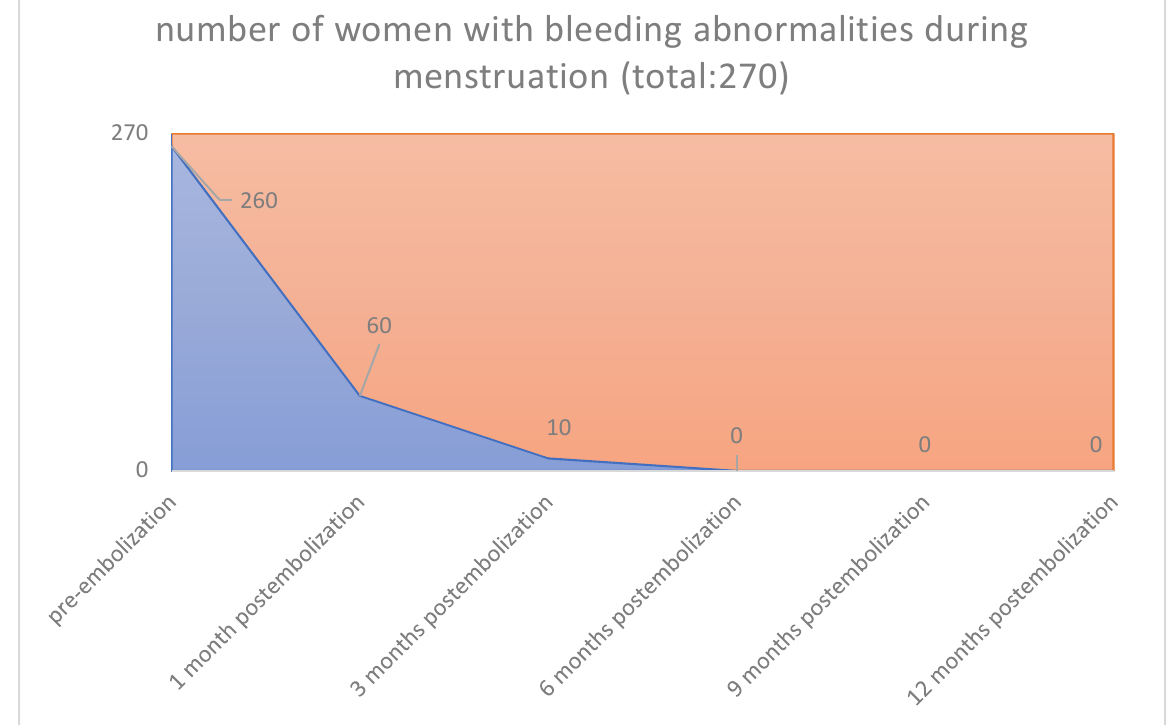
Figure 1. Bleeding abnormalities: Pre-embolization : Bleeding abnormalities during menstruation was reported in about 260 women out of a total 270 women. 1 Month postembolization from 260 women 60 report bleeding abnormalities during menstruation. 3 Months postembolization from 260 women only 10 participants report bleeding abnormalities during menstruation. 6 Months postembolization from 260 women 0 participants report bleeding abnormalities during menstru- ation. 9 Months postembolization from 260 women 0 participants report bleeding abnormalities during menstruation. 12 Months postembolization from 260 women 0 participants report bleeding abnormalities during